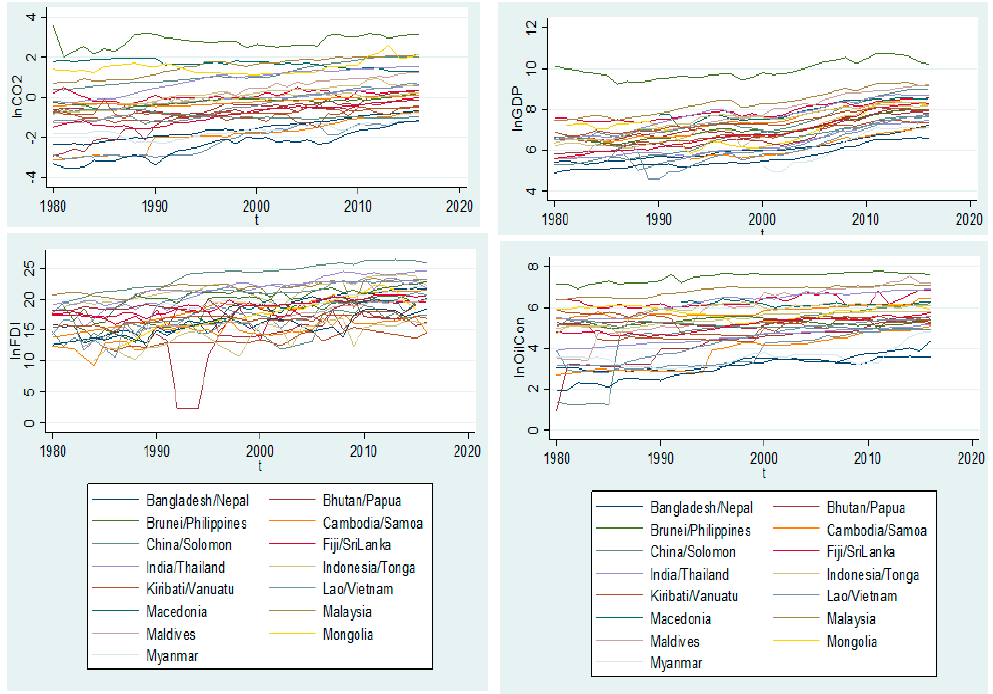
Figure A1. Line chart for the historical trend of variables: lnCO2, lnGDP, lnFDI, and lnOilCon over 1980 ‐ 2016.